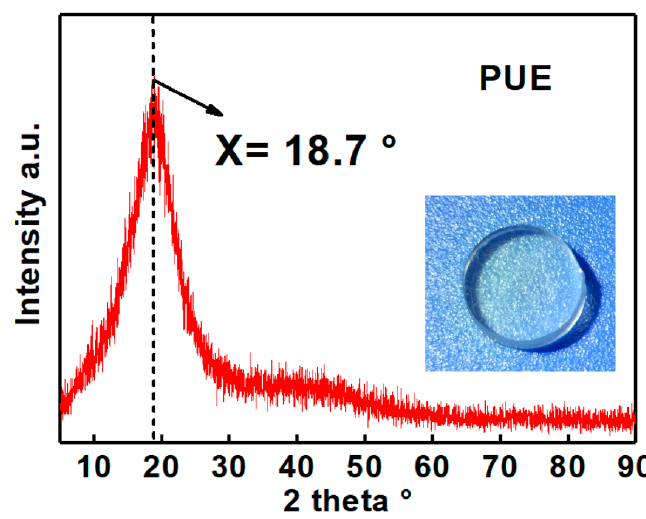
Figure 1. XRD analysis of the developed polyurethane elastomer (PUE) material, revealing a fully amorphous molecular microstructure, and the transparent characteristic as shown in inset.